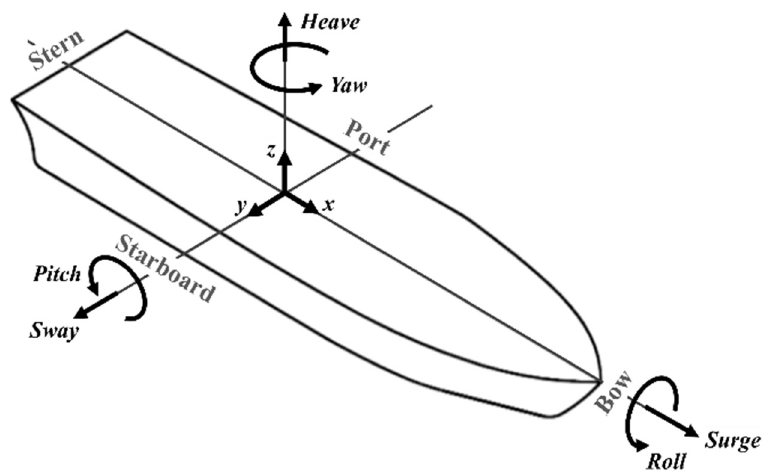
Figure 6. Six-degree of freedom ship motions.